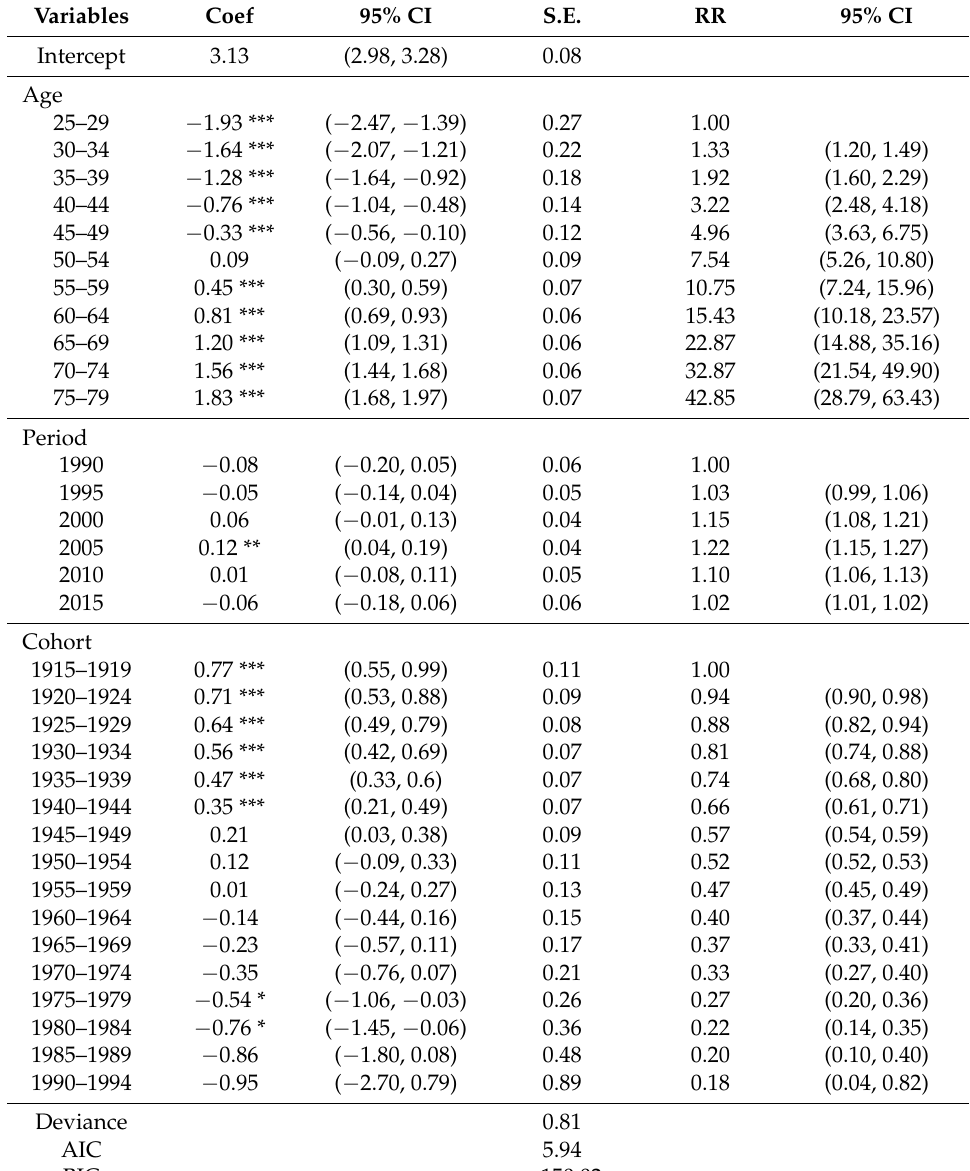
Table 1. Age-period-cohort (APC) model analysis results of stroke mortality-PM 2.5 in China.